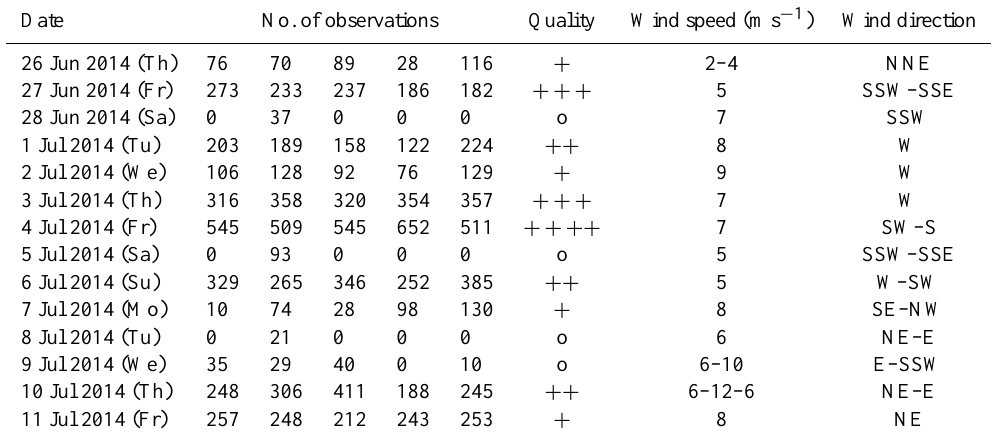
Table 2. Summary of all measurement days: number of observations at each site (Mahlsdorf, Charlottenburg, Heiligensee, Lindenberg, Lichtenrade), overall quality ranking of each day according to number of available observations and temporal coverage, ground wind speed and direction (classification from poor to excellent: o, + , ++ , +++ , ++++ )